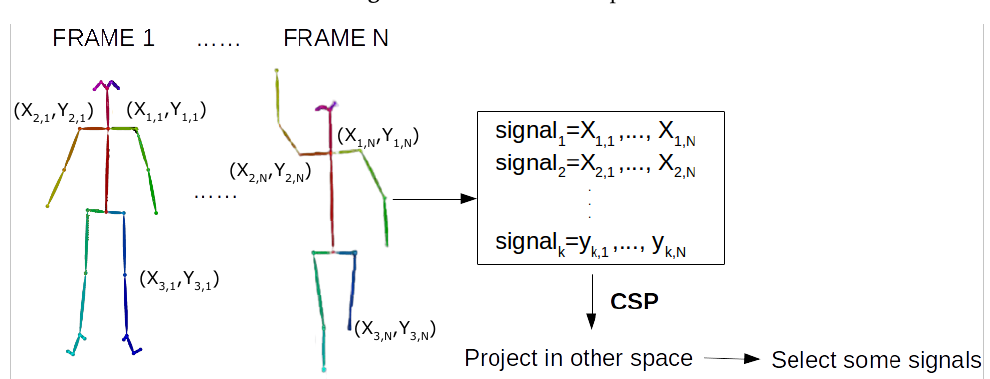
Figure 2. Proposed